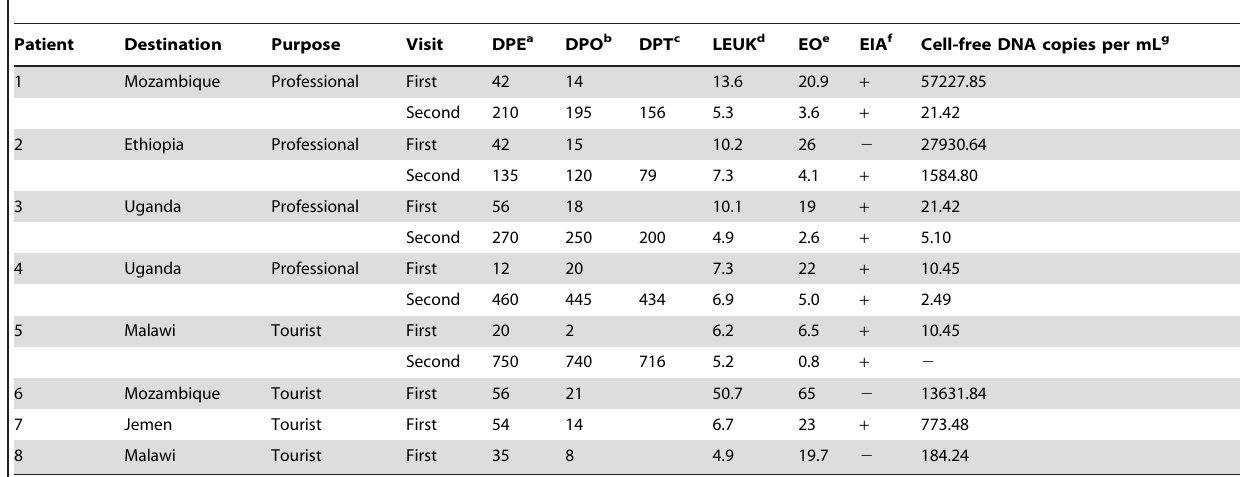
Table 2. Patients with Katayama